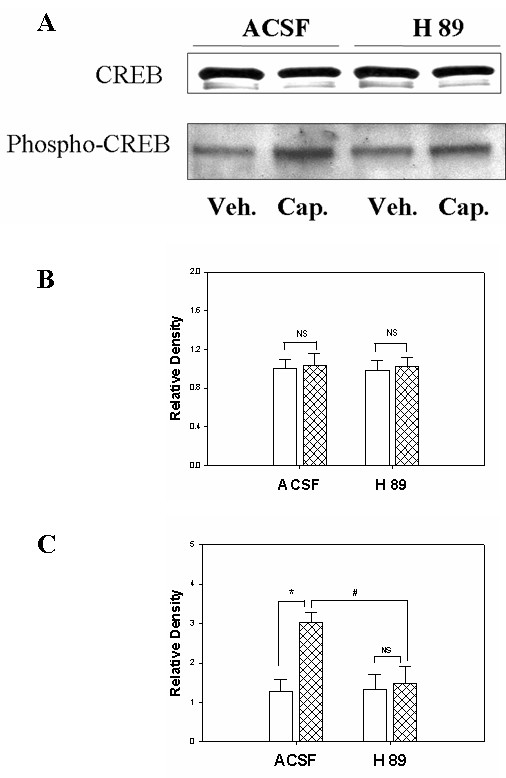
Expression of CREB protein and phospho-CREB protein in spinal cord in rats and the effect of intrathecal PKA inhibitor, H89, treatment. Panel A. Immunoblot bands of CREB and phospho-CREB protein expression. Panel B. Bar graph summarizing the density of the immunoblot CREB bands. (NS, no significance between vehicle treatment vs. capsaicin treatment group with either ACSF- or H89- treatment). Panel C. Bar graph showing the density of the immunoblotting bands of phospho-CREB protein. (*, p < 0.05; the value from vehicle treatment vs. capsaicin treatment; #, p < 0.05, the value of ACSF-treated vs. H89-treated animals after capsaicin injection; NS, no significance between vehicle vs. capsaicin treatment in groups with H89 intrathecal administration; n = 5 in each group). Open bar, vehicle group; hatched bar, capsaicin group.